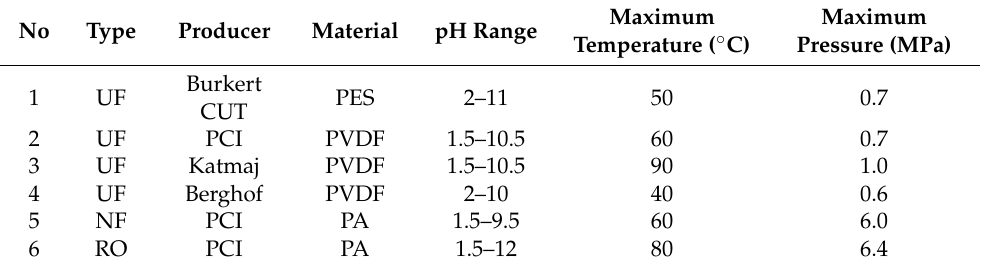
Table 4. The limit values of the working parameters of the membranes.